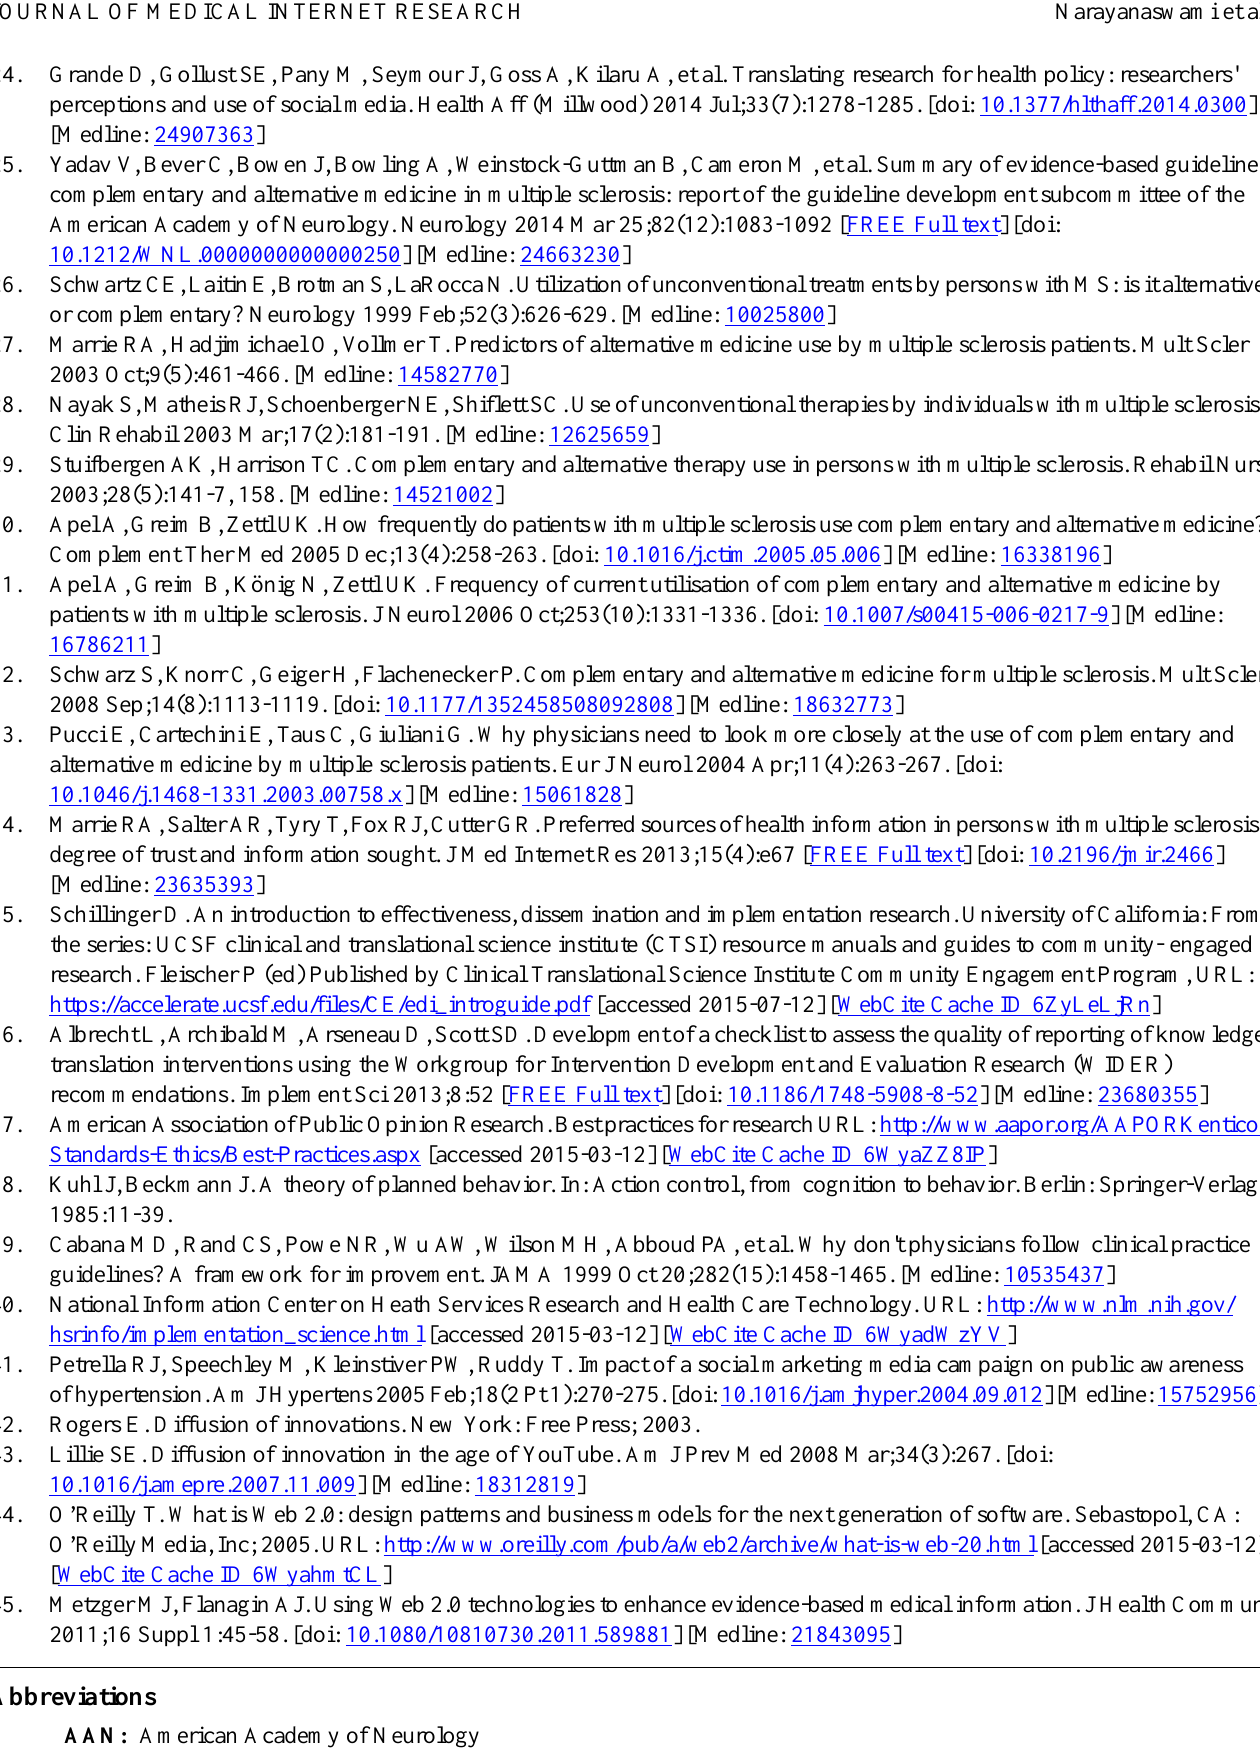
AD: absolute difference CAM: complementary and alternative